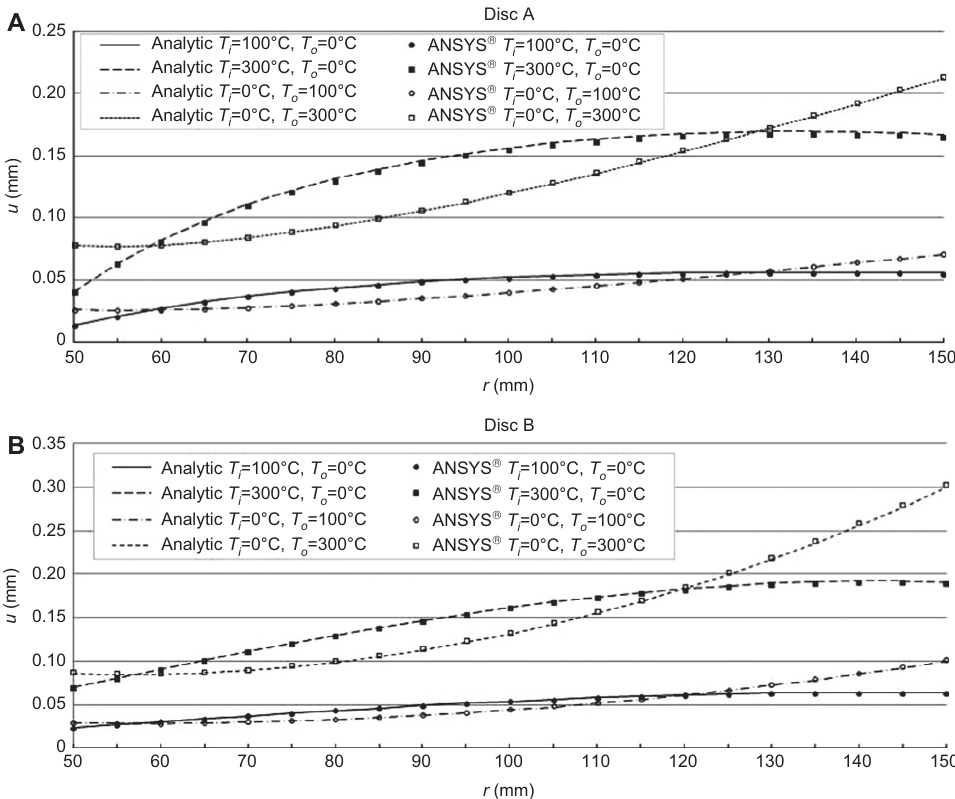
Figure 9 Variations of radial displacements at Disc A (A) and Disc B (B) under linearly increasing and decreasing